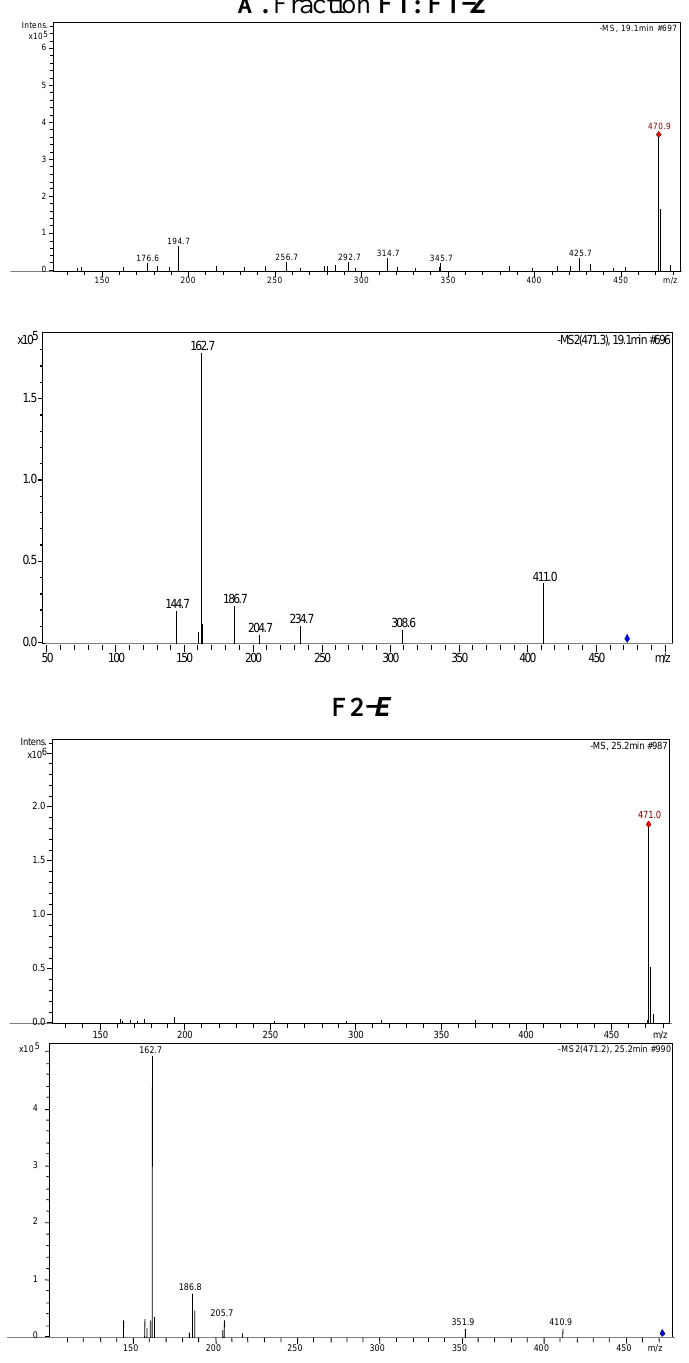
Figure 3. MS and MS-MS spectra of peaks ( F1 -Z, F2 -E ) at m/z 471 from fraction F1 (A); MS and MS-MS spectra of peaks ( F1 -Z, F2 -E ) at m/z 471 from fraction F2 (B) . A. Fraction F1: F1